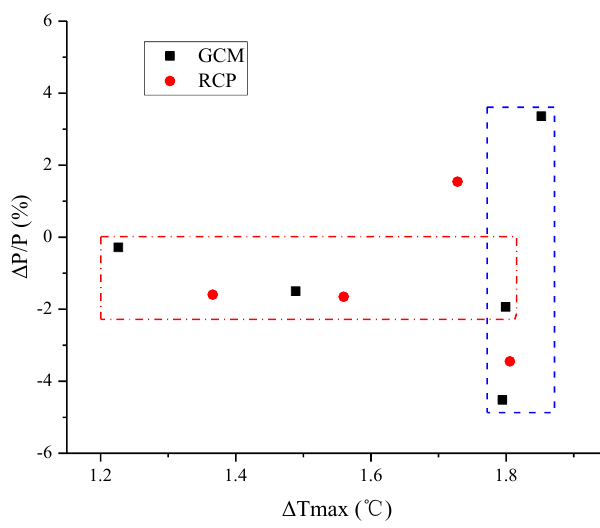
Figure 8. Projected changes ( (cid:49)) in annual mean precipitation ( P ) and maximum temperature ( T max ) averaged over ESMs or